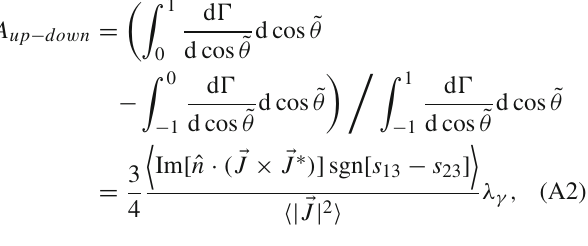
Table 2 Decay chains involving a kaon resonance decaying via K +